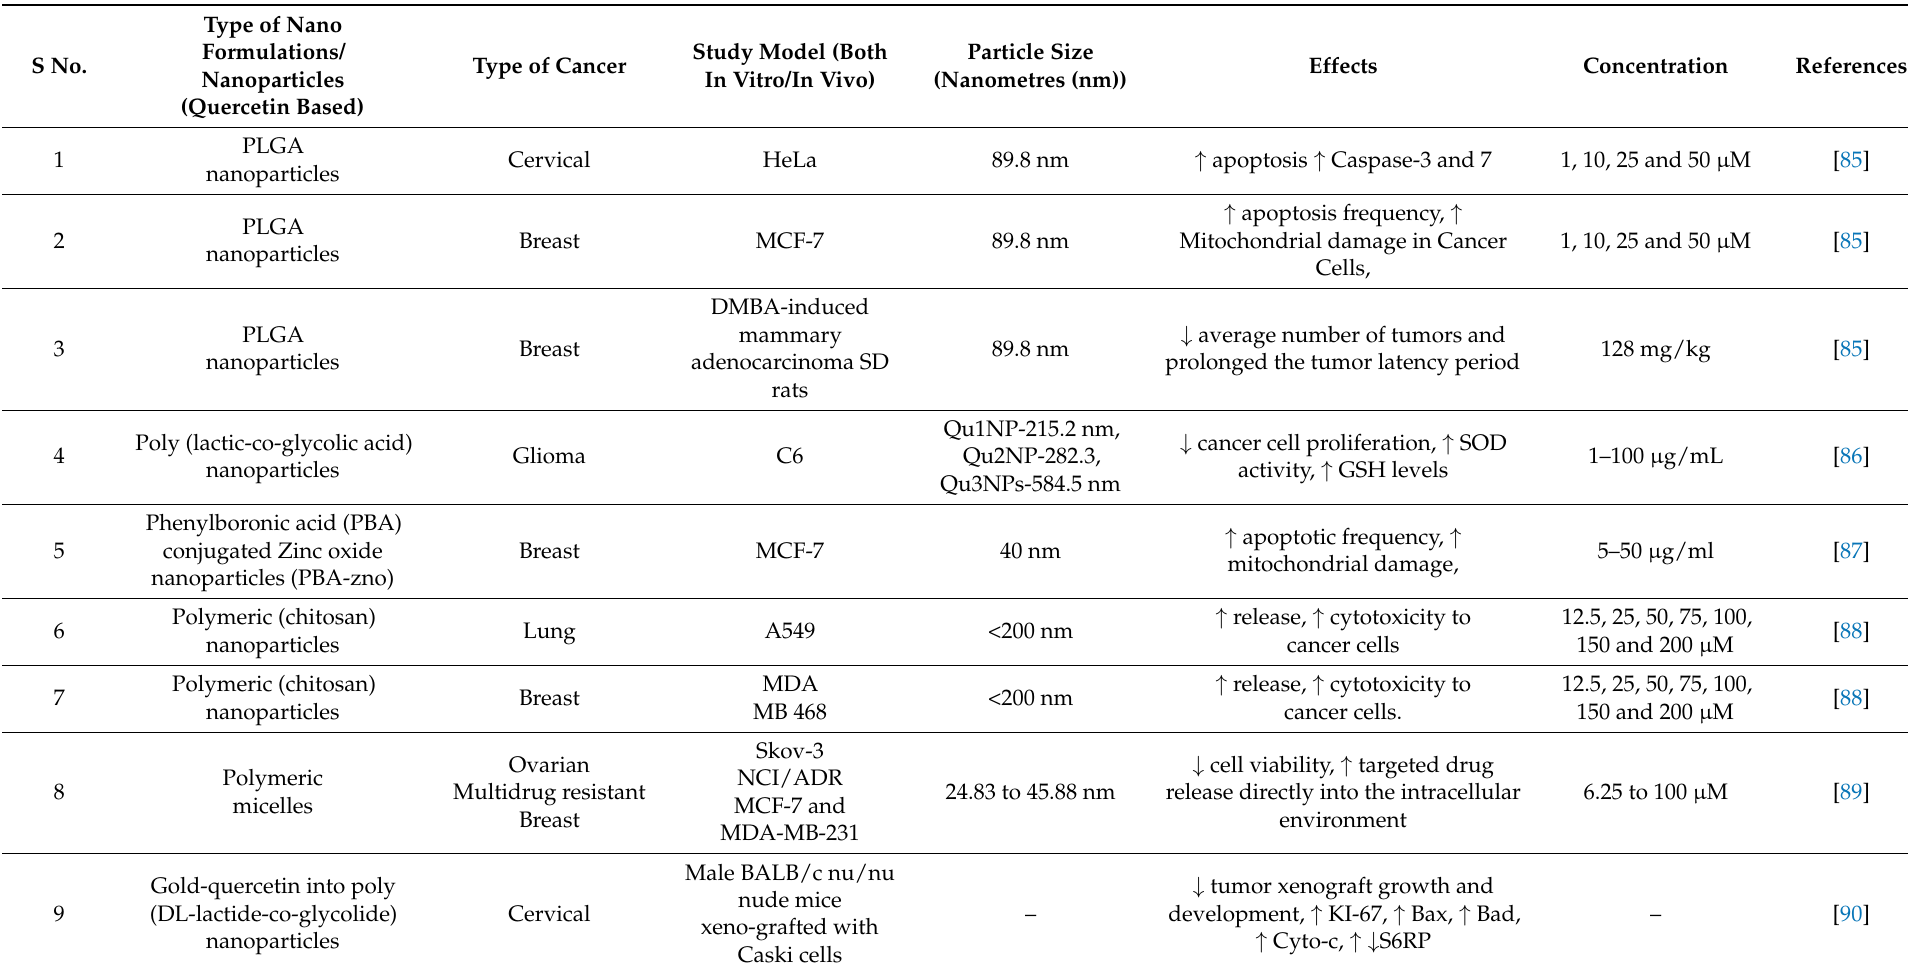
Table 1. Anti-Cancer effects of various types of quercetin nano-formulations based delivery systems.